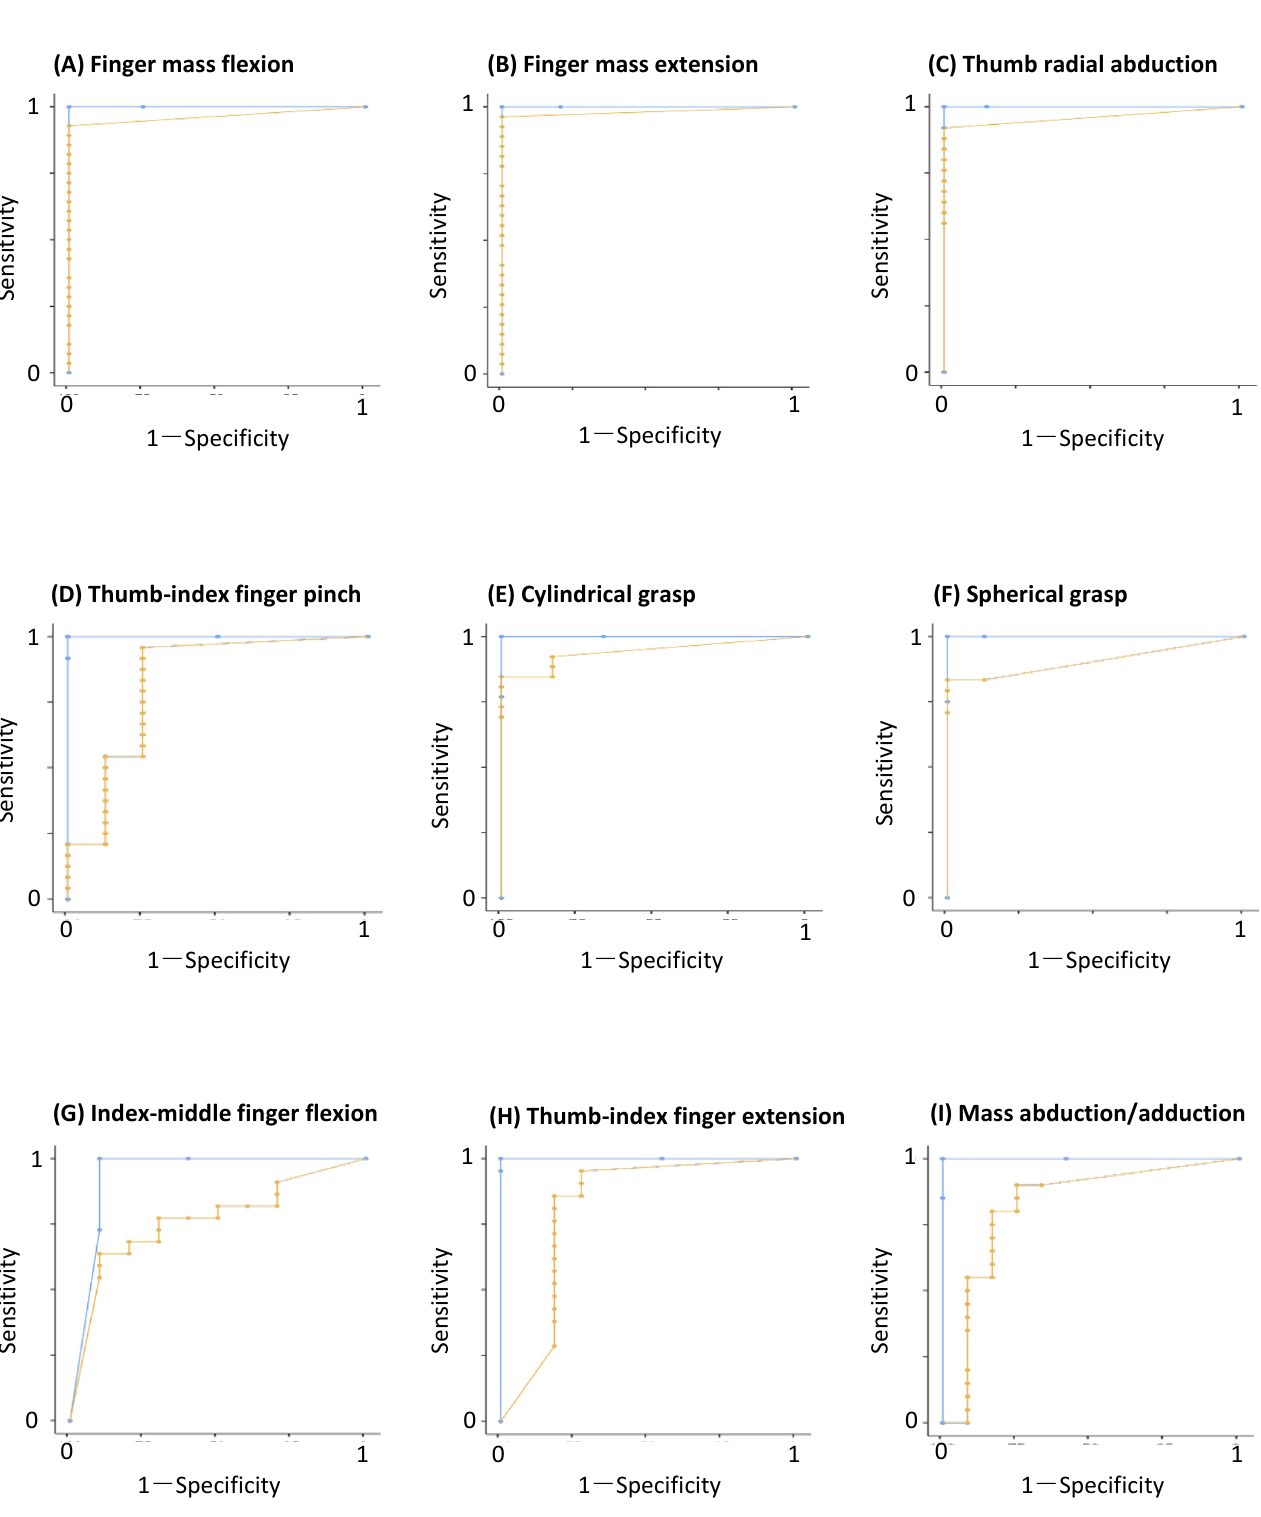
Figure 4. Receiver operating characteristic (ROC) curves for each of the nine tasks. The light blue curve was estimated by three therapists (insufficient movement = 0, well-accomplished movement = 1). The orange curve was determined using the values determined with Fahrenheit , and the therapist’s clinical judgment.